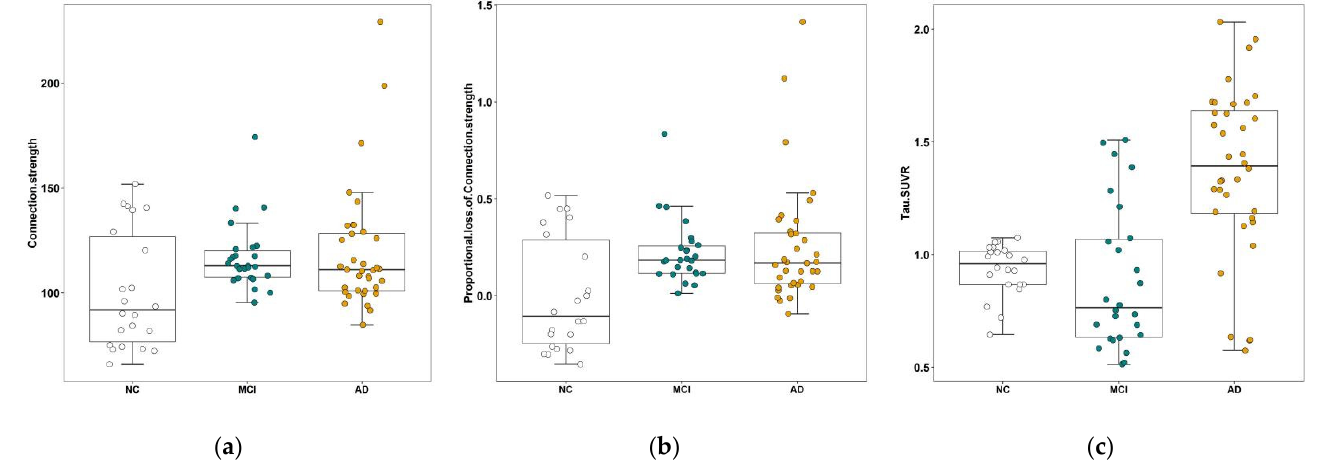
Figure 1. Comparison of connection strength, PLFCS and tau SUVR between the three groups. ( a ) The global FCs of NC, MCI and AD groups. ( b ) The comparison of global PLFCS between NC, MCI and AD groups. ( c ) The comparison of global tau SUVR between the NC, MCI and AD groups. Abbreviations: NC, normal control; MCI, mild cognitive impairment; AD, Alzheimer’s disease.